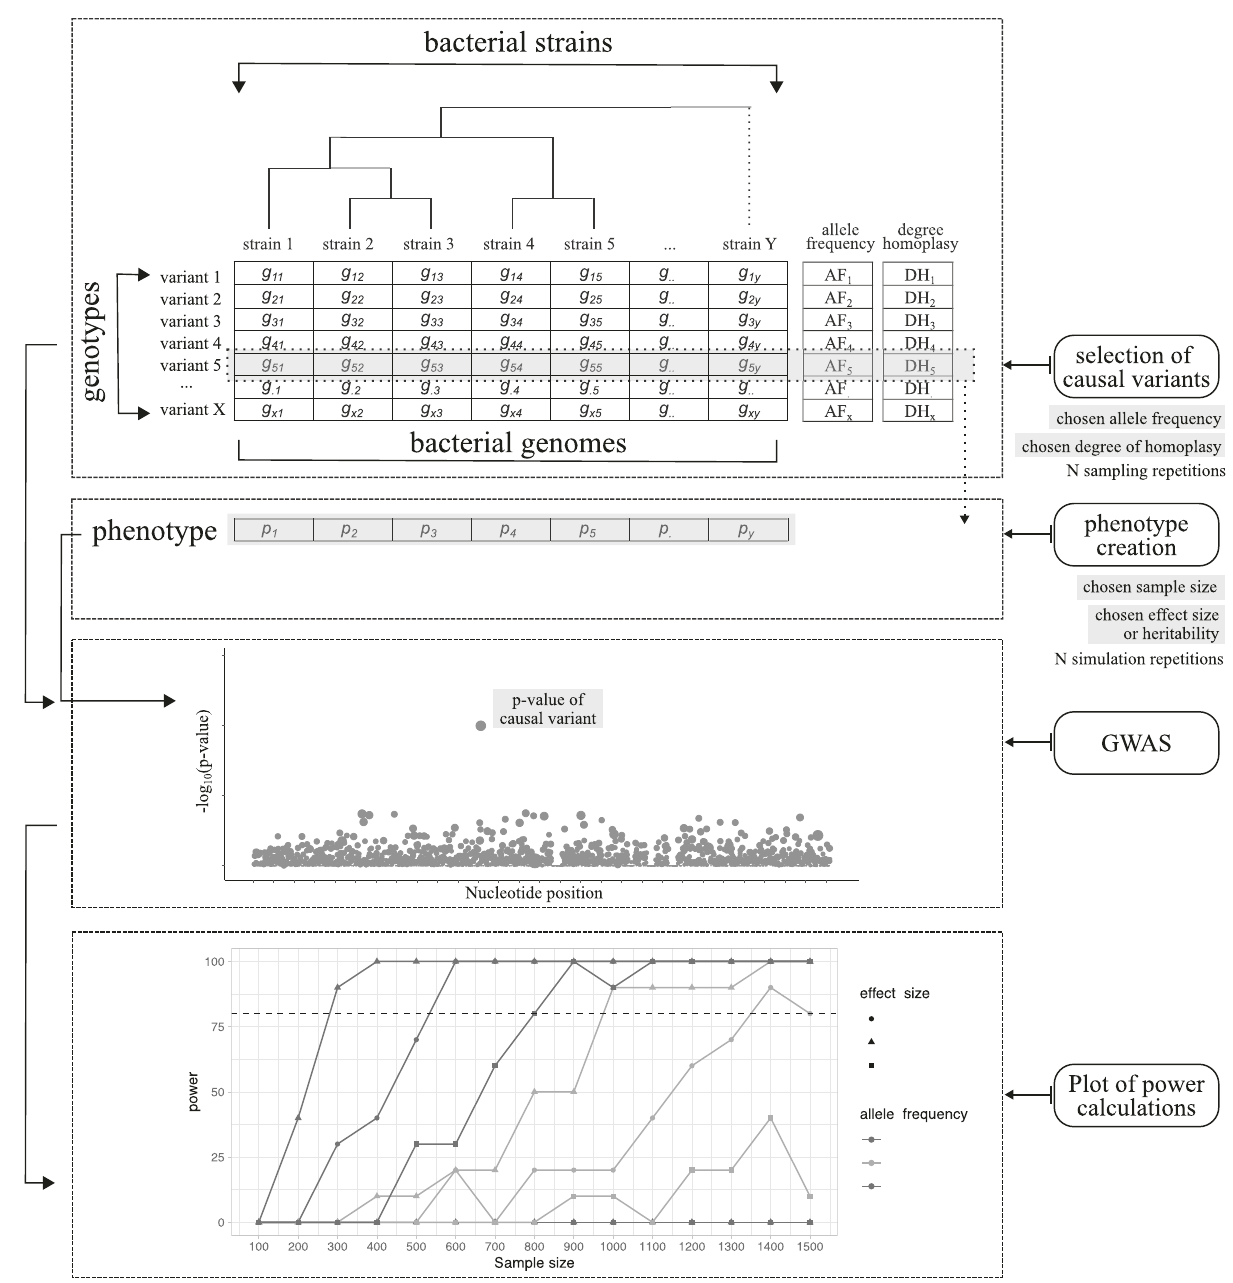
Fig. 1 Approach to bacterial GWAS power calculations. Four steps were implemented to conduct power calculations. First, known or randomly sampled causal variants are chosen from existing genotypes, in the sub-sampling or phenotype simulation approach, respectively. In the latter, causal variants meeting a range of selected MAF and degree of homoplasy are selected. Second, phenotypes are either modi fi ed from existing ones (sub-sampling approach) or simulated from randomly selected genotypes (phenotype simulation approach) to achieve the range of chosen sample sizes and effect sizes (or heritability values). Third, a genome-wide association study (GWAS) is conducted for each combination of parameters and p -values of causal variant extracted. And forth, power is calculated as the proportion of GWAS replicates in which the causal variant is above the Bonferroni-corrected genome-wide signi fi cance